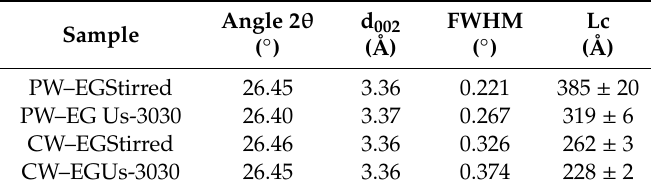
Figure 8. X-ray di ff raction(XRD) patterns for wax compounds containing EG. ( a ) XRD patterns showing the crystalline nature of the wax compounds. XRD pattern of the (002) peak of graphite for ( b ) para ffi n wax and ( c ) candelilla wax compounds. Table 3. Results of crystallite size for wax